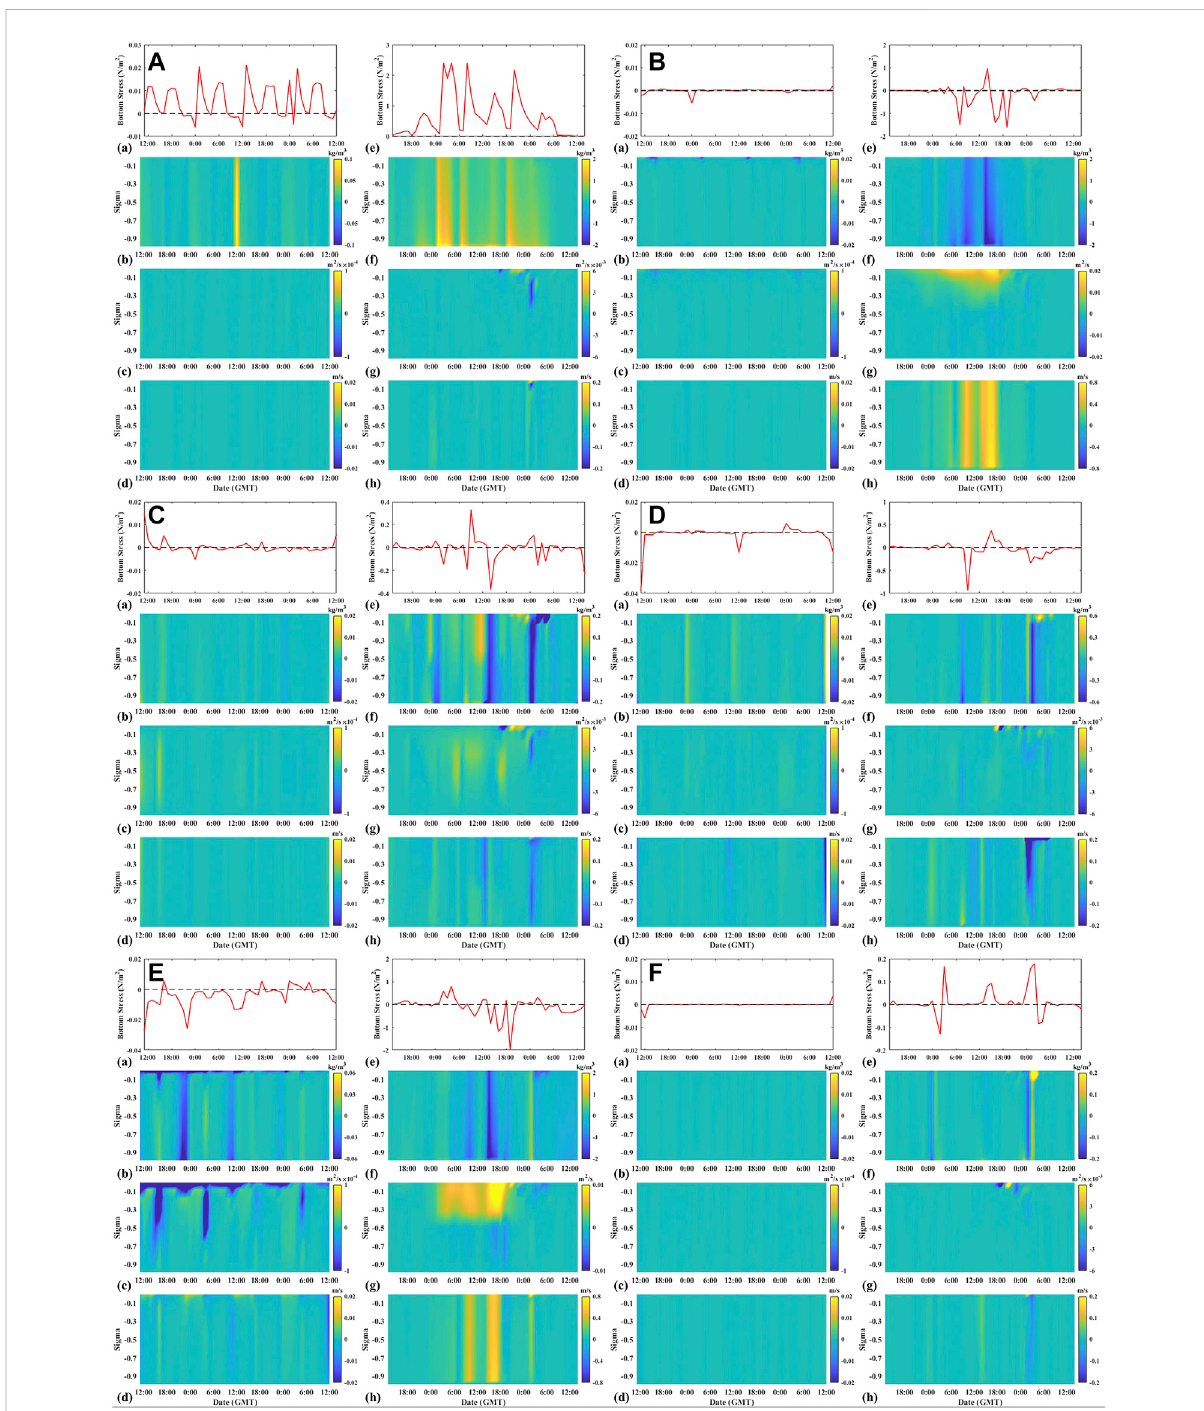
FIGURE 13 Differencesbetween (A) Test1andTest2, (B) Test1andTest3, (C) Test1andTest4, (D) Test1andTest5, (E) Test1andTest6,and (F) Test1and Test 7. (a) bottom bed shear stress, (b) SSC, (c) K m and (d) current velocity during calm weather (averaged in 50 h before the typhoon) at station P2. (e – h) are the same as (a – d) except for Typhoon Mitag (averaged in 50 h during the